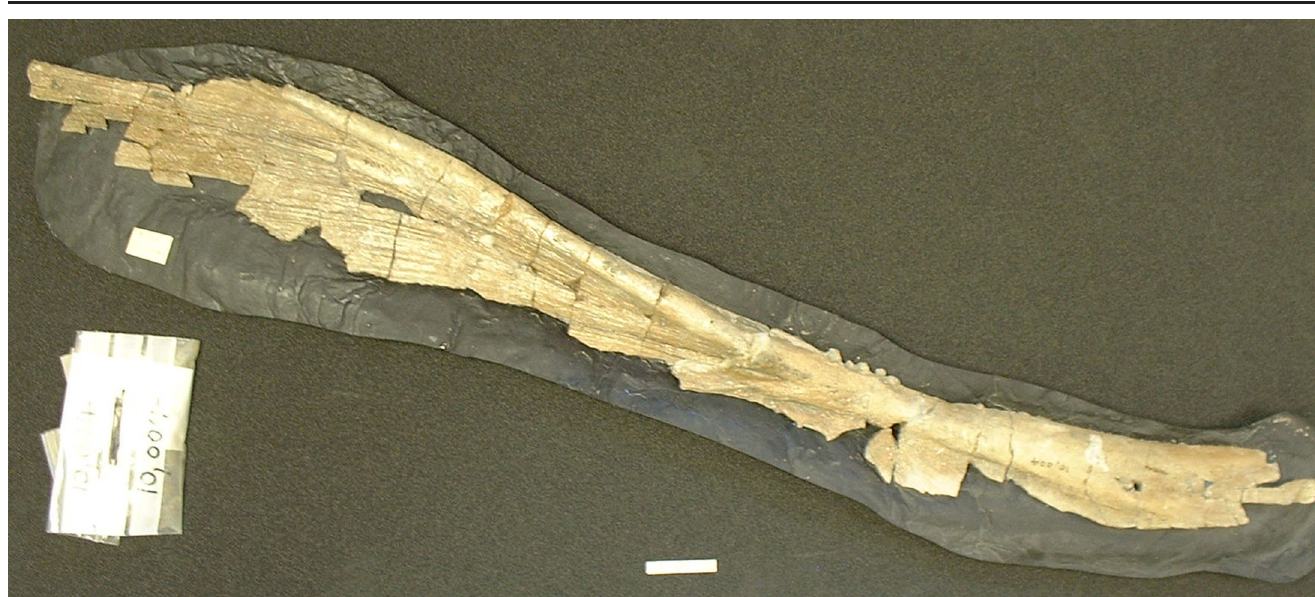
Figure 5. Left maxilla of Leedsichthys (PETMG F.174/10,004, 1047 mm long), with five peg-like crushing teeth orientated near the apex of the jaw line. Scalebar = 50